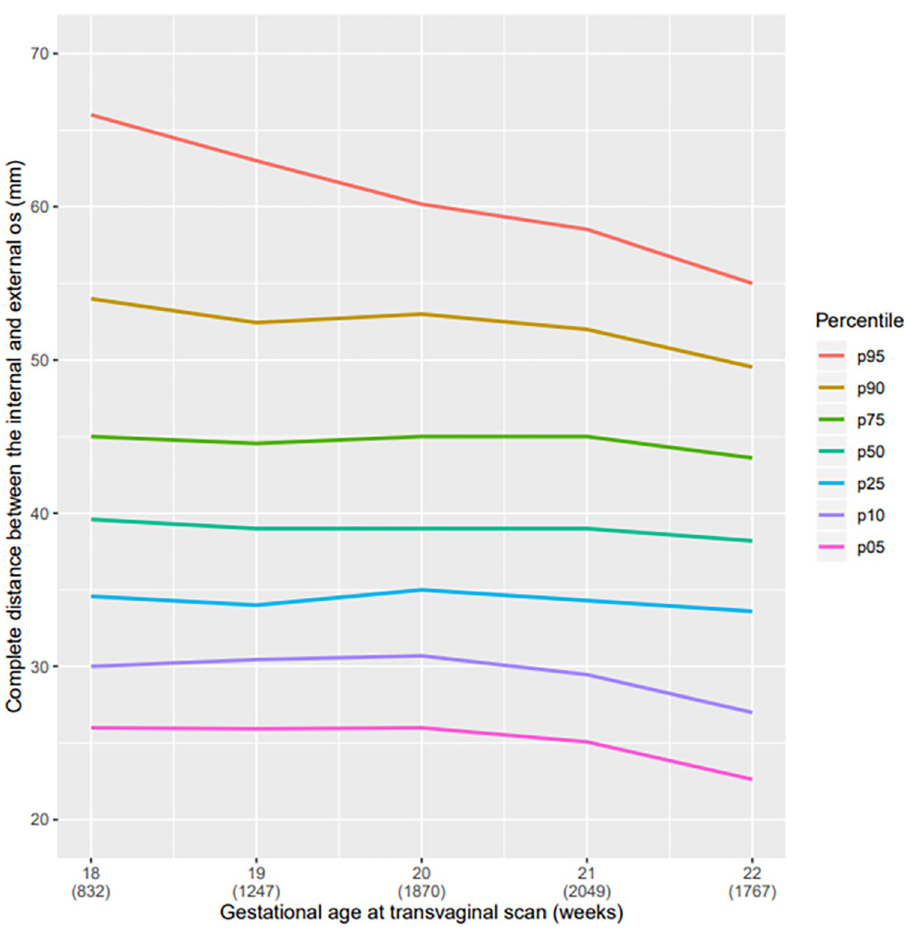
Fig 5. Curve of percentile values for the curve CL measurement. Curve of percentile values for the curve distance between the internal and external os according to gestational age (weeks) at transvaginal scan.